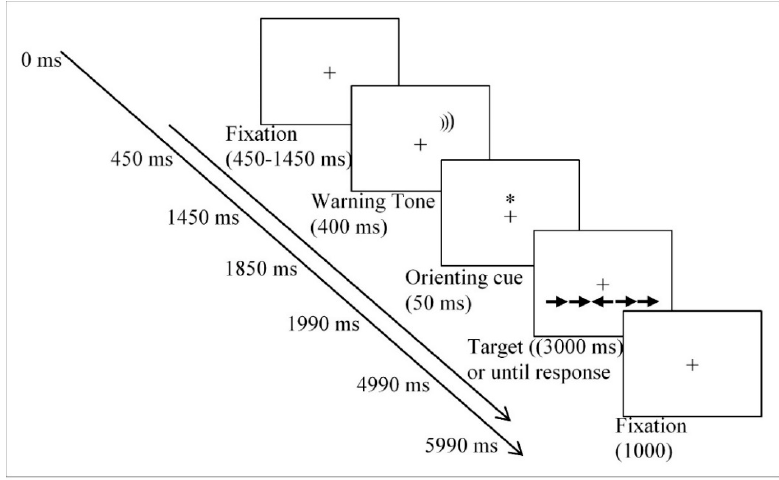
Figure 1. Example of procedure in the ANT-I (Attentional Network Test-Interactions). The timing of events is presented on the left.